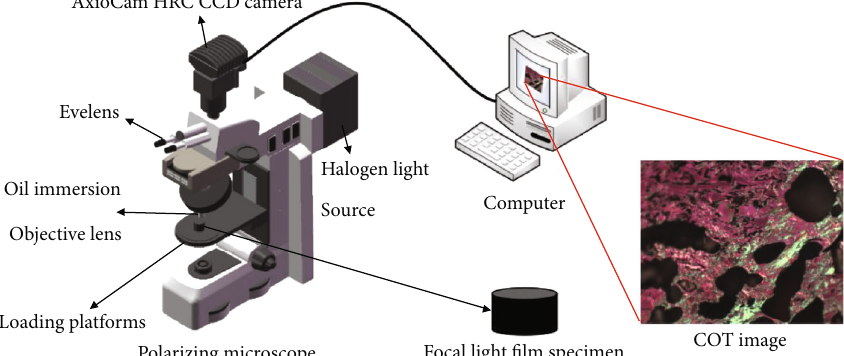
Figure 1: The acquisition process of COT image.